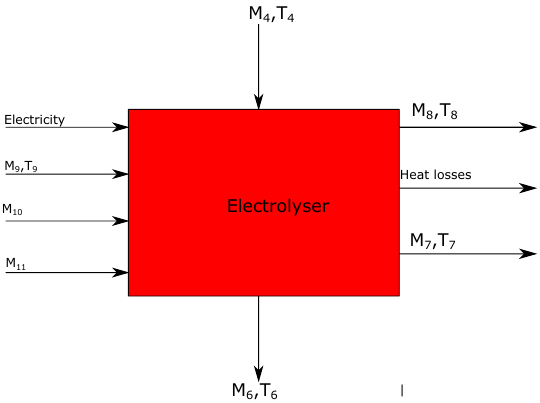
Figure 5. Mass and energy flow through the electric arc furnace.